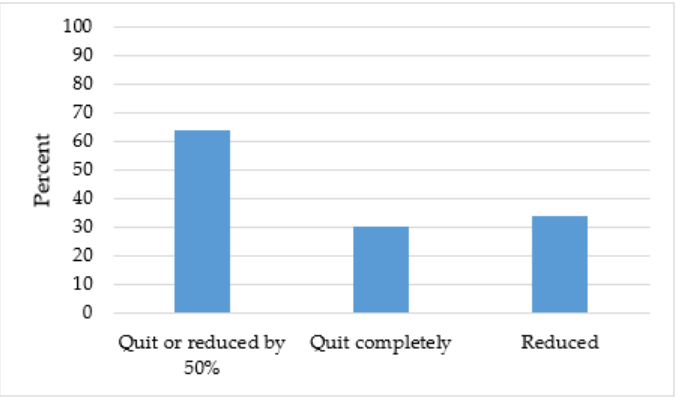
Figure 3. Self-reported quit and reduction rates among n = 211 survivors enrolled in the Tobacco Treatment Program. Reduced = reduced daily cigarettes by at least 50%.